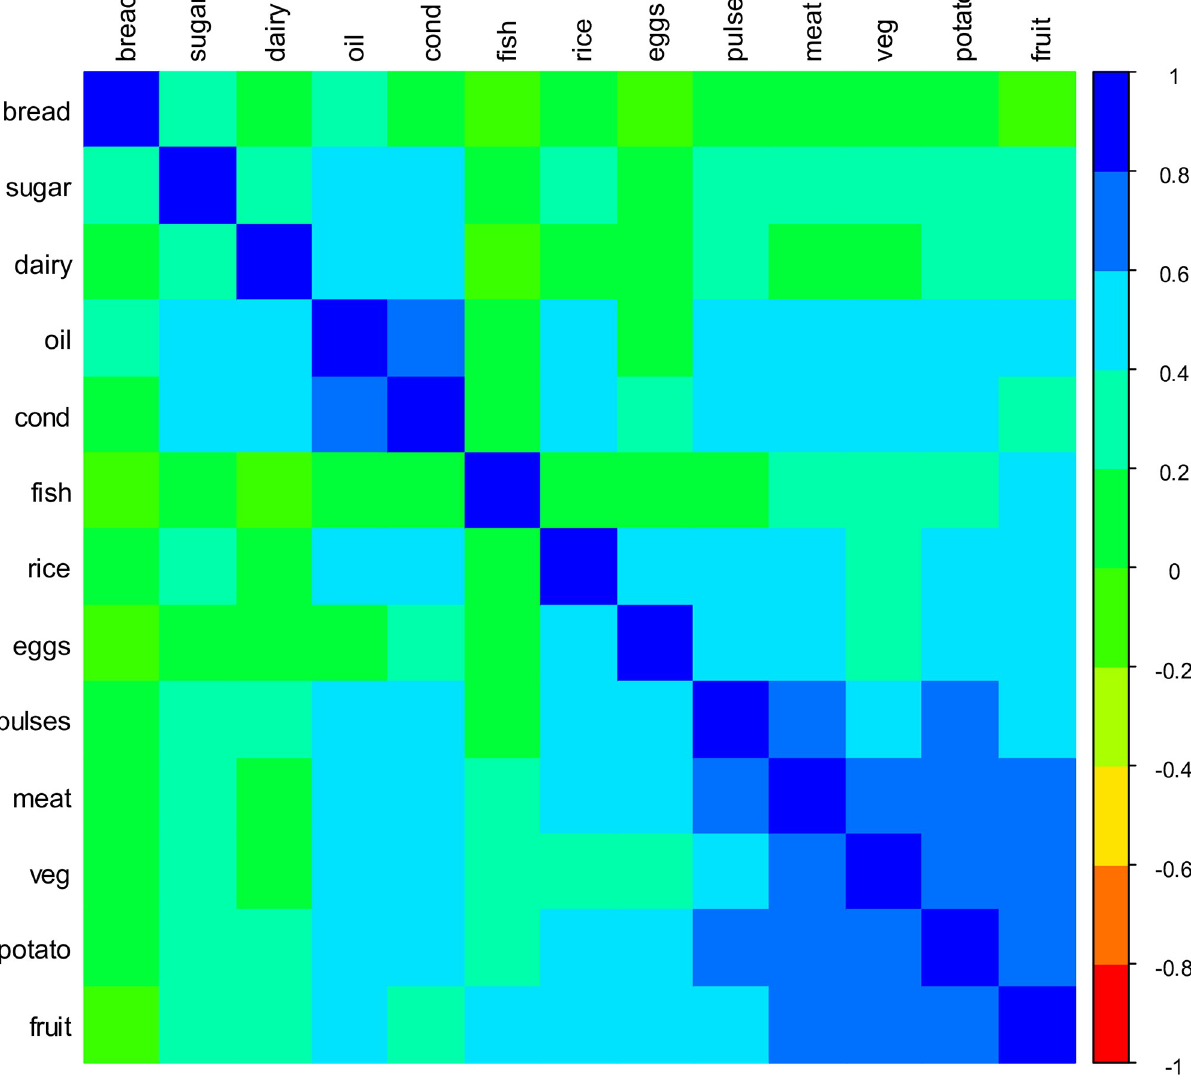
Fig 3. Estimated random effects correlation matrix for Ibb in